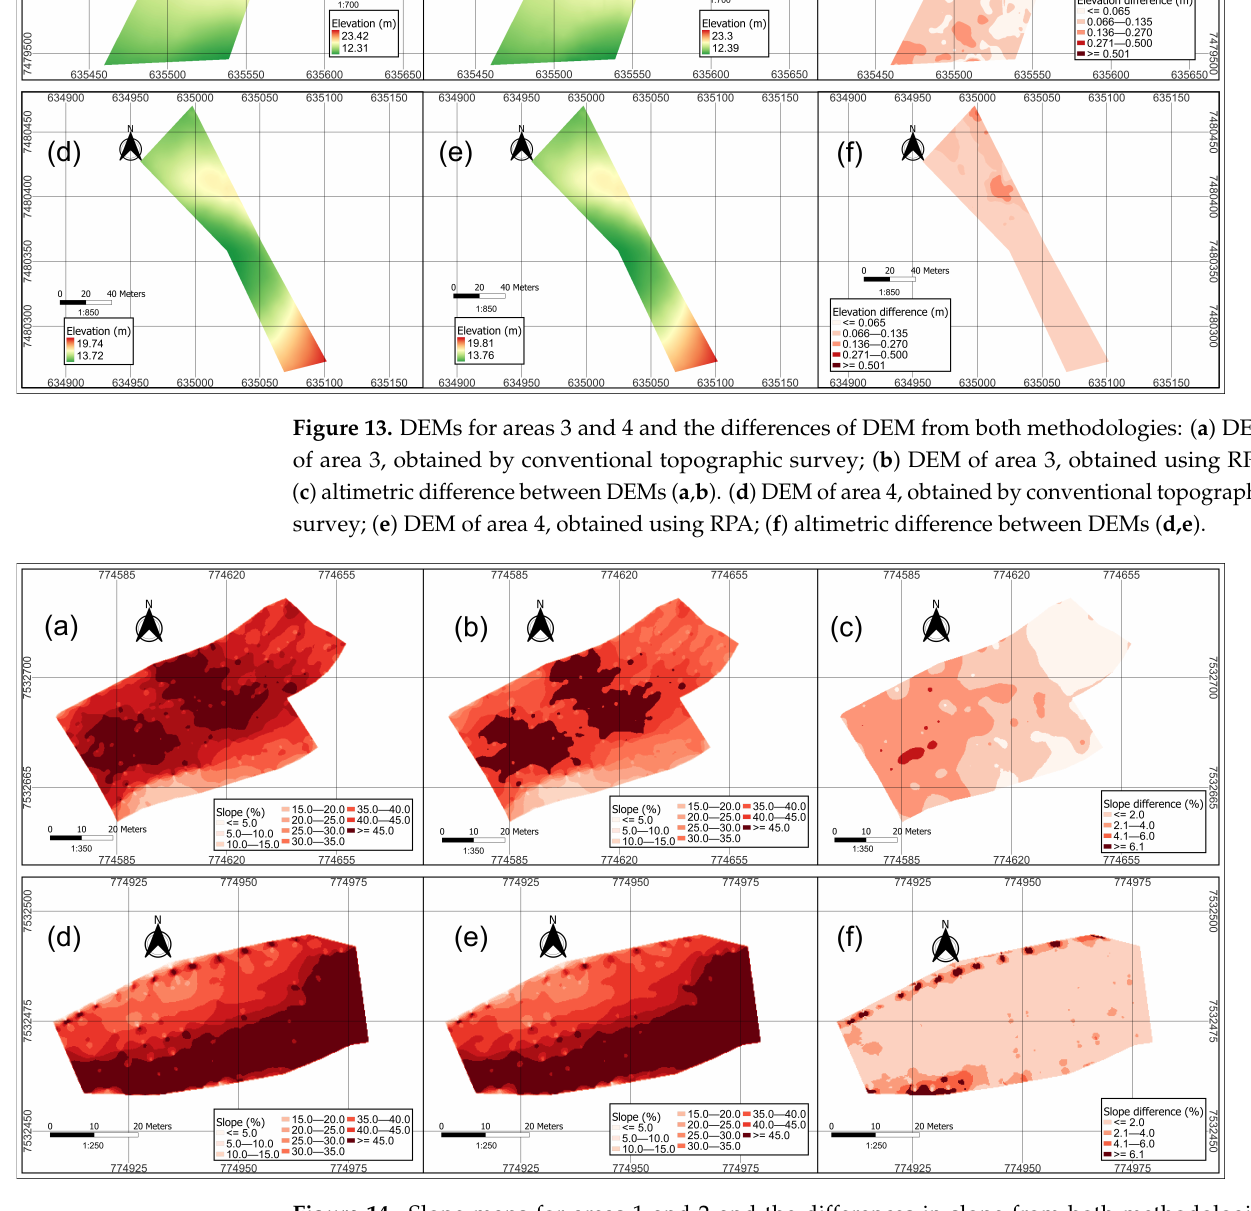
Figure 14. Slope maps for areas 1 and 2 and the differences in slope from both methodologies: ( a ) slope map of area 1, obtained by conventional topographic survey; ( b ) slope map of area 1 obtained using RPA; ( c ) difference between slope maps ( a , b ). ( d ) slope map of area 2 obtained by conventional topographic survey; ( e ) slope map of area 2 obtained using RPA; ( f ) difference between slope maps ( d,e